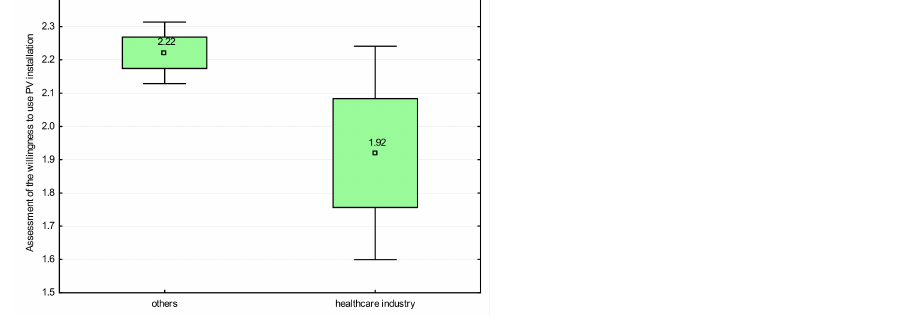
Figure 11. Which sectors of the economy are most affected by the decarbonization policy (medical industry) vs. assessment of the willingness to use PV installations?